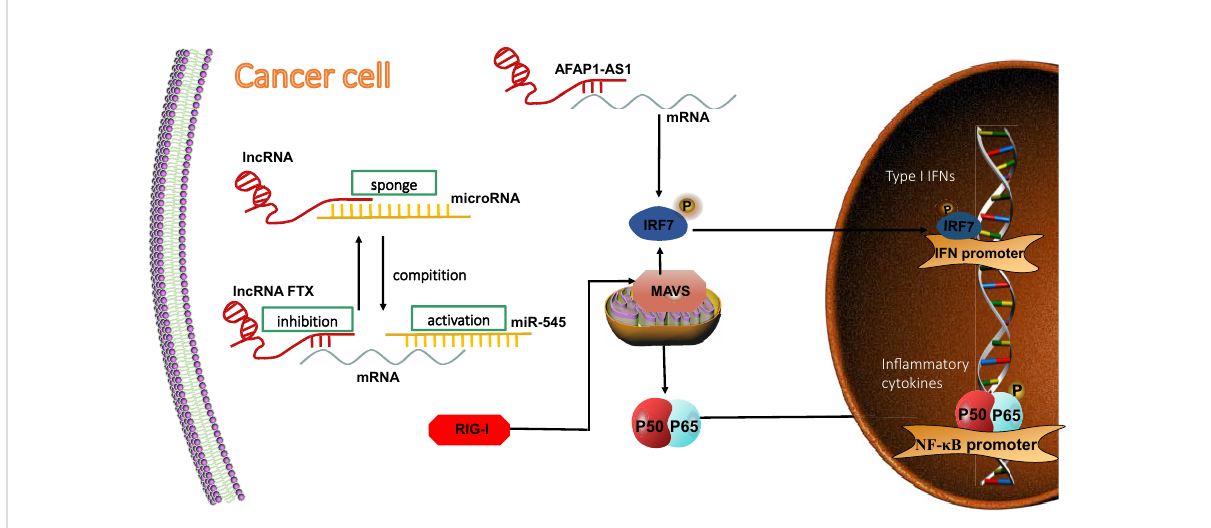
FIGURE 4 LncRNA regulates RIG-I signaling pathway in tumor cells. LncRNAs competitively bind to miRNA and indirectly inhibit miRNA-targeted mRNA expression, thereby inhibiting the activation of the RIG-I downstream signaling pathway. RIG-I acts as a direct target of miR-545. LncRNA FTX competitively binds to miR-545, thereby inhibiting mRNA expression in HCC cells. LncRNA AFAP1-AS1 affects mRNA, activating the positive- feedback regulation loop of IFN signaling and promoting migration and invation of NSCLC.